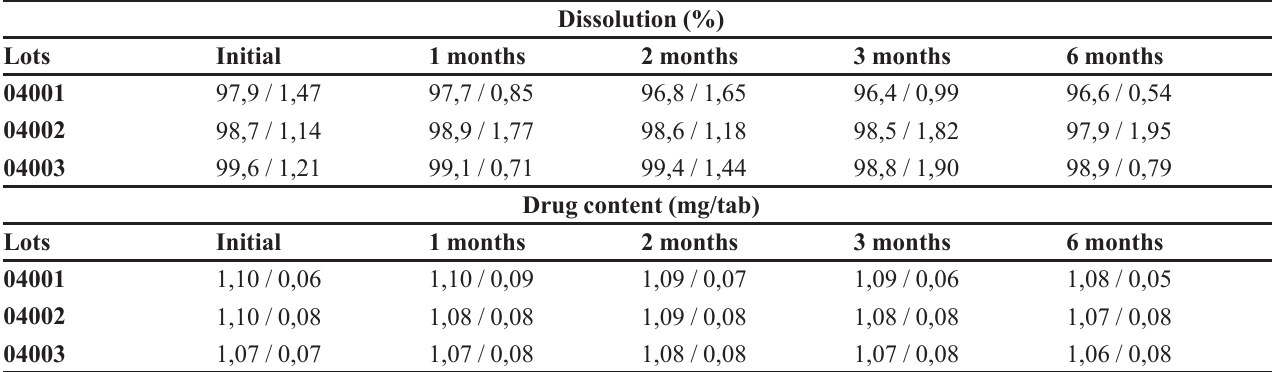
TABLE I - Analytic results of the lots under accelerated stability conditions